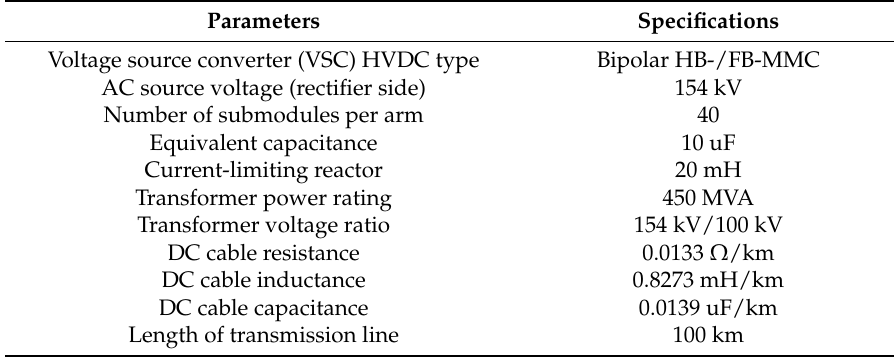
Table 1. Summary of high-voltage direct-voltage (HVDC) system